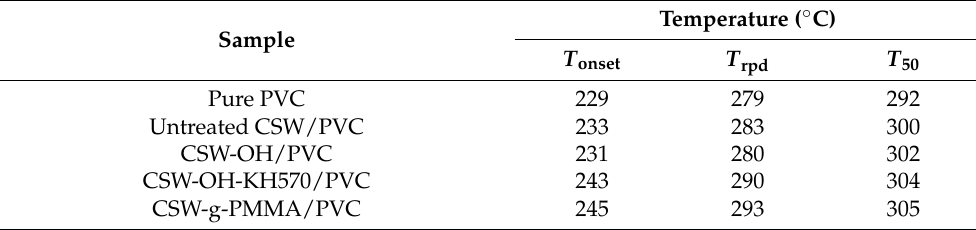
Figure 9. The thermogravimetric curves ( a ) and derivative thermogravimetric curves ( b ) of pure PVC, untreated CSW/PVC, CSW-OH/PVC, CSW-OH-KH570/PVC, and CSW-g-PMMA/PVC. Table 1. Decomposition stability of PVC composites.